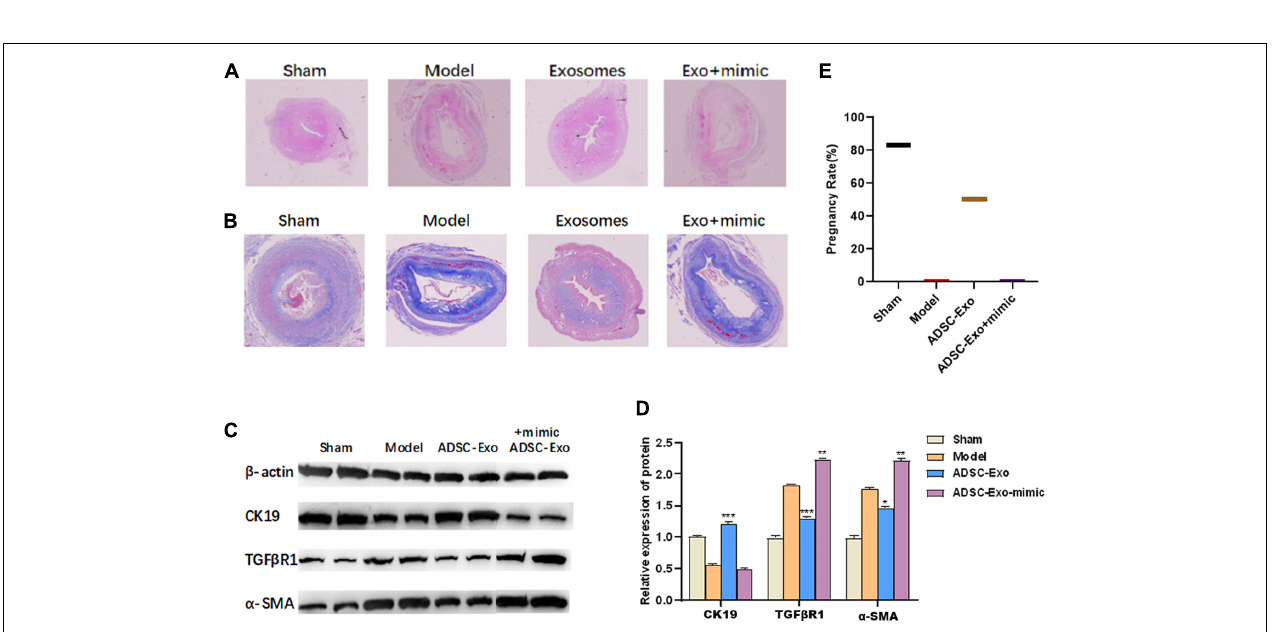
FIGURE 4 | LncRNA-MIAT in ADSC-Exos alleviates mouse endometrial fibrosis by targeting miR-150. (A) The number of glands and levels of fibrosis were detected by H&E staining of the endometrial tissue from mouse endometrial fibrosis models (magnification, × 20). (B) The number of glands and levels of fibrosis were detected by Masson staining of the endometrial tissue from mouse endometrial fibrosis models (magnification, × 20). (C) The pregnancy rate was measured in each group of mouse endometrial fibrosis models. (D,E) Western blot analysis of CK19, TGF β R1 and α -SMA protein expression in the endometrial tissue of mouse endometrial fibrosis models. Data are presented as the mean ± SD ( n = 3). * P < 0.05, ** P < 0.01, *** P < 0.001. H&E, hematoxylin-eosin; ADSC-Exos, adipose-derived mesenchymal stem cells-exosome; CK19, cytokeratin 19; TGF β R1, homo sapiens transforming growth factor beta receptor 1; α -SMA, alpha smooth muscle actin. SD, standard